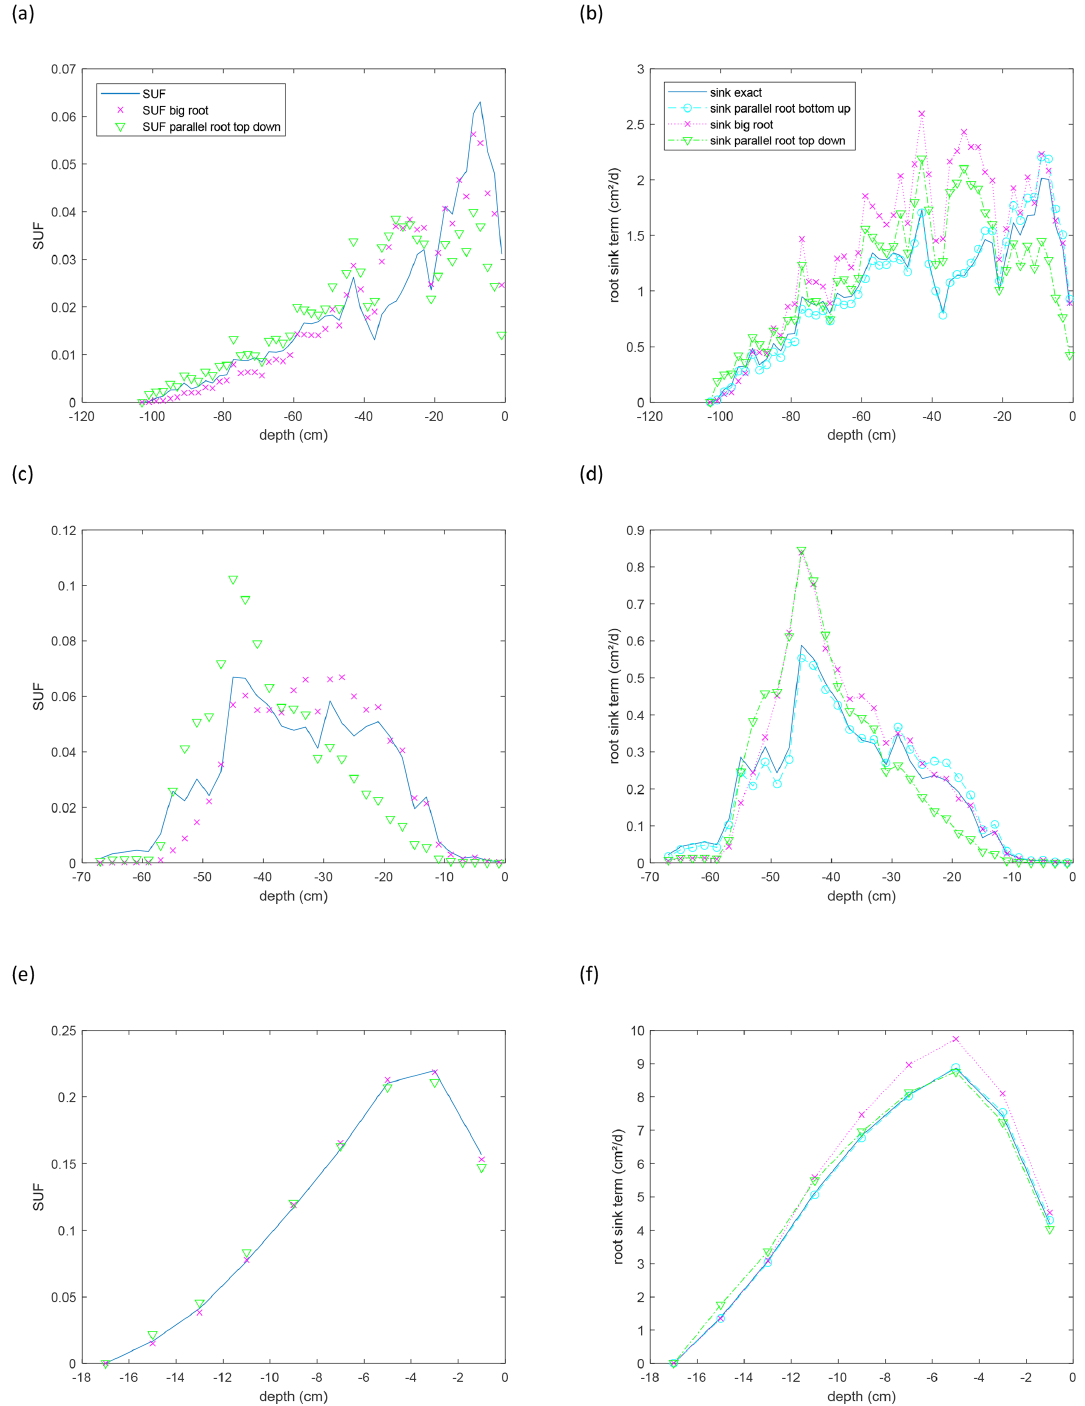
Figure 10. Depth profiles of scaled up standardized uptake fractions ( SUF s) (a, c, e) and sink term distribution normalized by the considered soil layer thickness (2cm) for a non-uniform soil water potential distribution ( − 3000cm at the soil surface and 0cm at the maximal root depth) (b, d, f) for the maize (a, b) , sunflower (c, d) , and grass (e, f) root systems shown in Fig. 9. Approximations are calculated for the parallel root with a bottom-up parameterization using the exact SUF and K rs , the big root model, and the parallel root model with a top-down parameterization, with SUF estimated from the radial root segment conductivities. Sink terms are divided by the thickness of the soil layer, 2cm, over which the root segment sink terms are